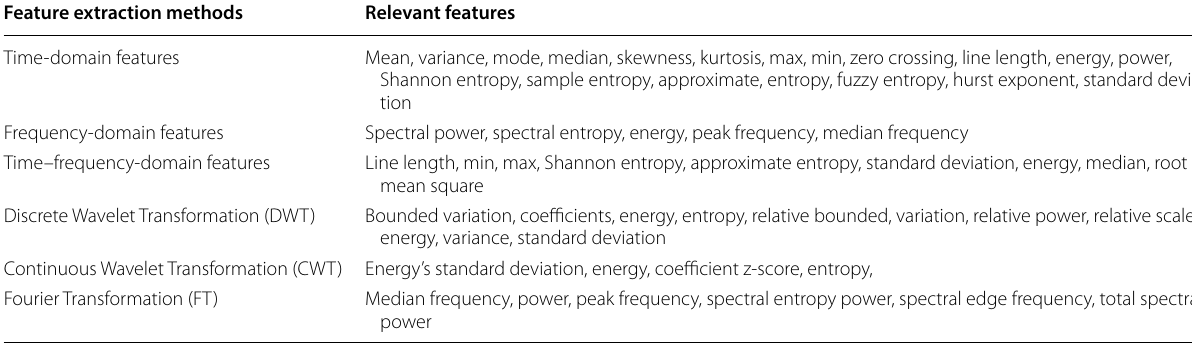
Table 1 Feature extraction methods and features used on EEG signal dataset Feature extraction